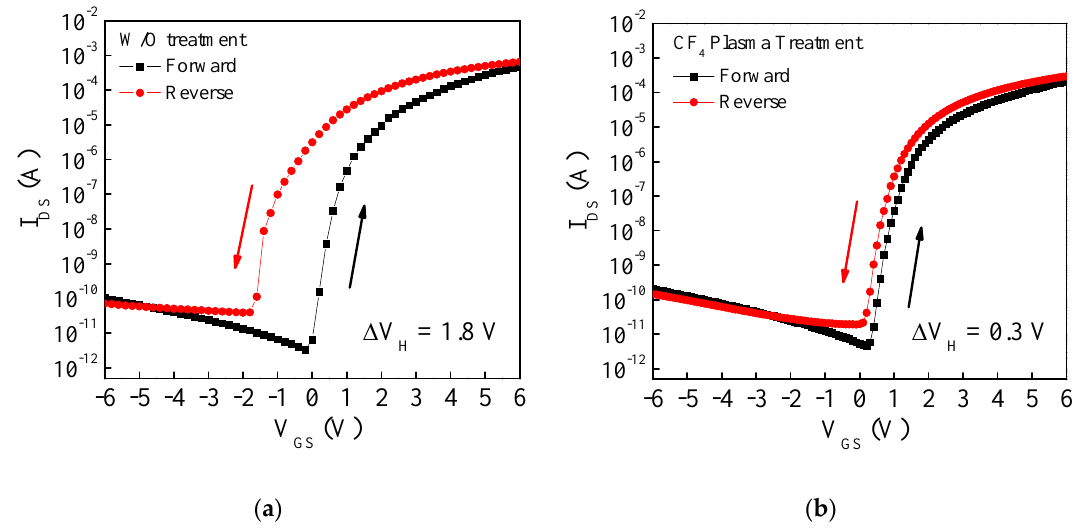
Figure 4. Hysteresis measurement of amorphous indium-gallium-zinc oxide (a-IGZO) thin-film transistor (TFT) with and without the CF 4 plasma treatment.